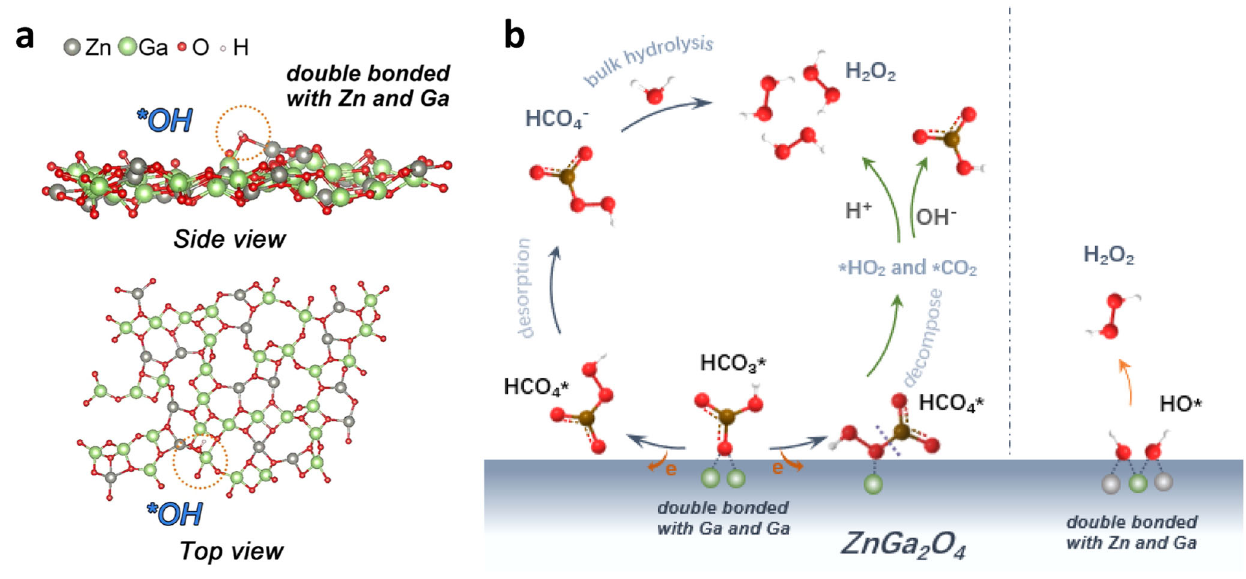
Fig.5|ProposedreactionpathwaysofwateroxidationtoH 2 O 2 .a Sideviewandtopviewofadsorptionof*OHonZnGa 2 O 4 . b Schemeillustrationoftheproposeddirect and indirect pathways toward H 2 O 2 generation on the ZnGa 2 O 4